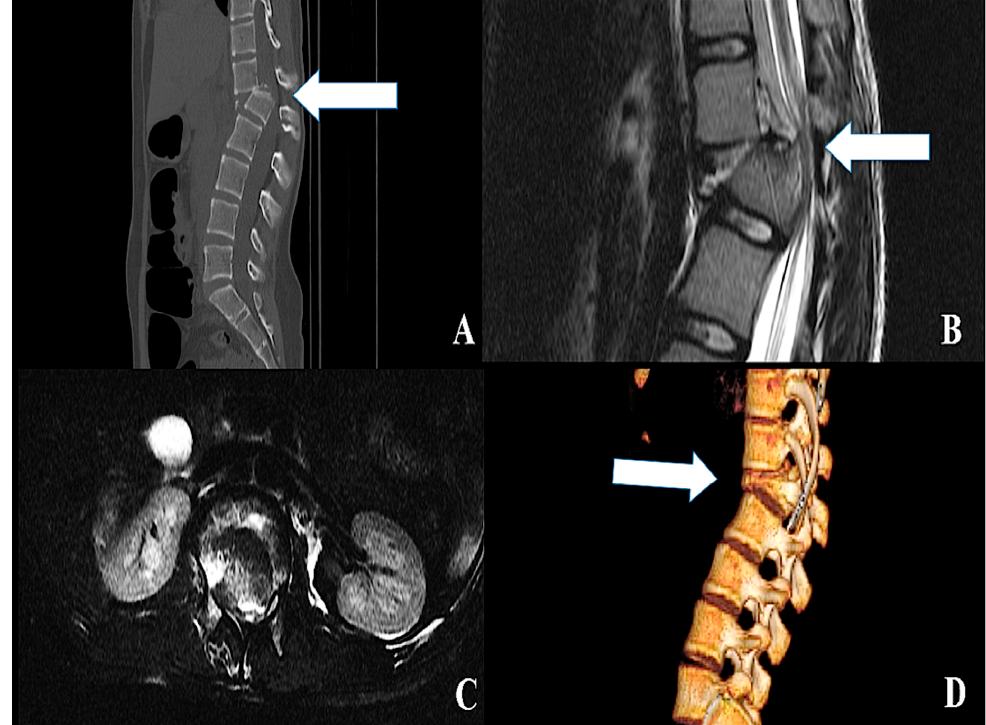
Figure 1. ( A ) Computed tomography (CT) scan disclosing a Thoracolumbar “C” type Spine